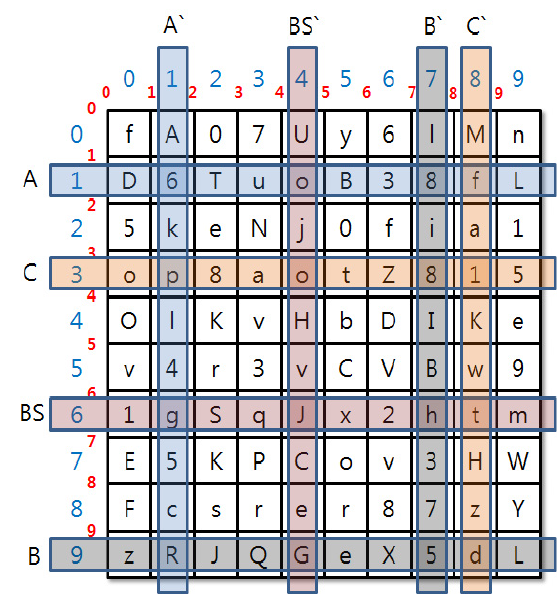
Figure 7. Identity Key Creation